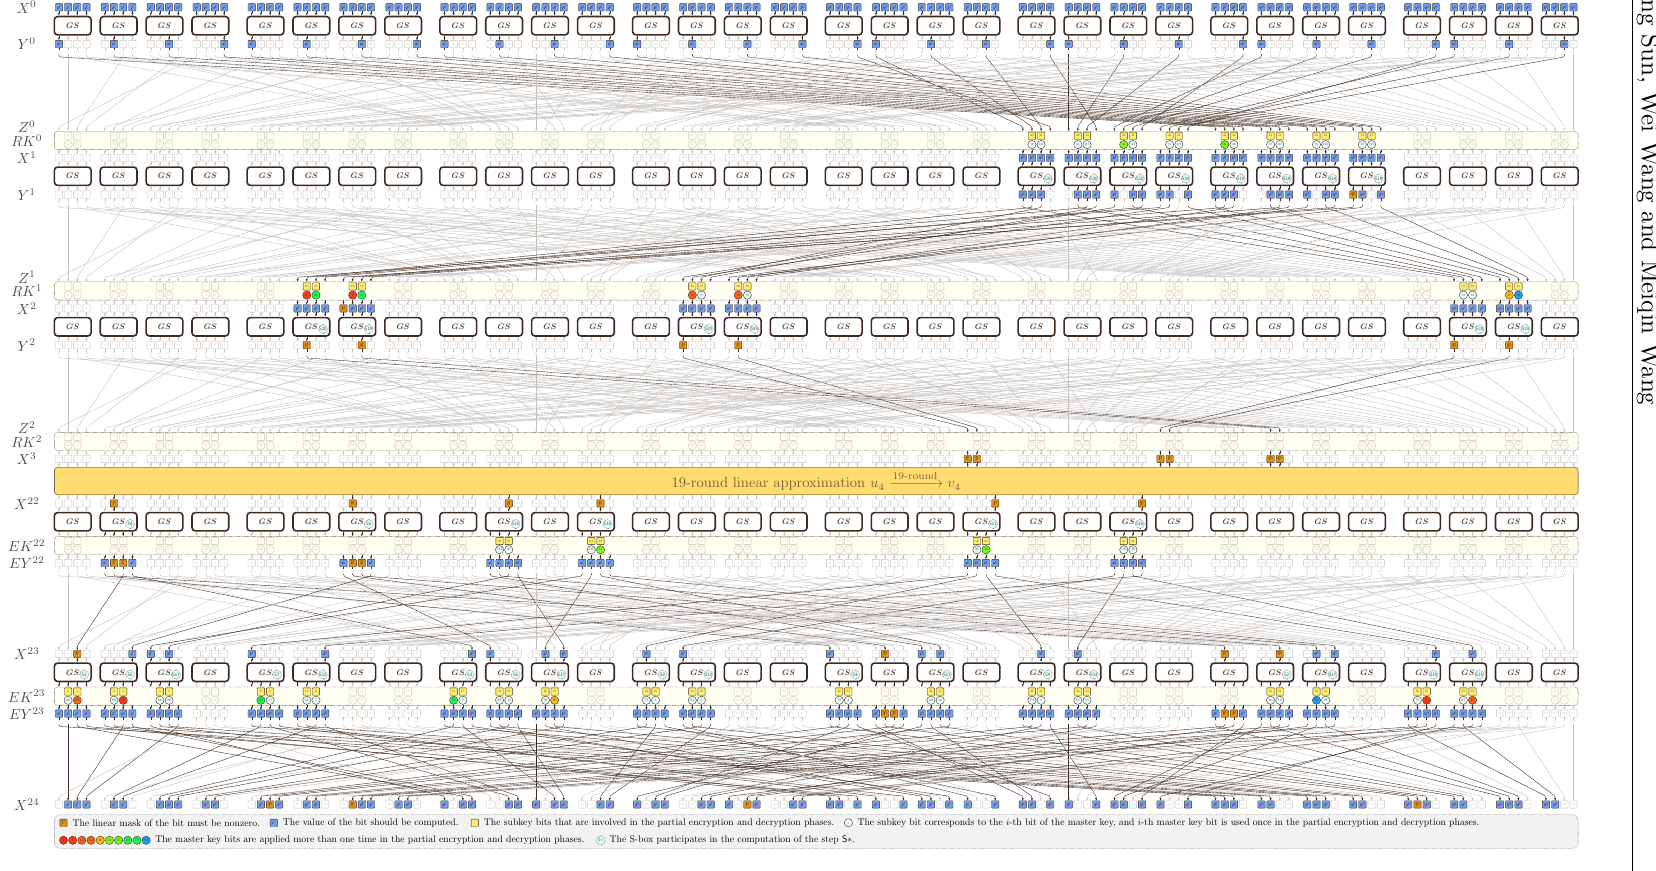
Figure 12: Key-recovery attack on 24-round GIFT-128